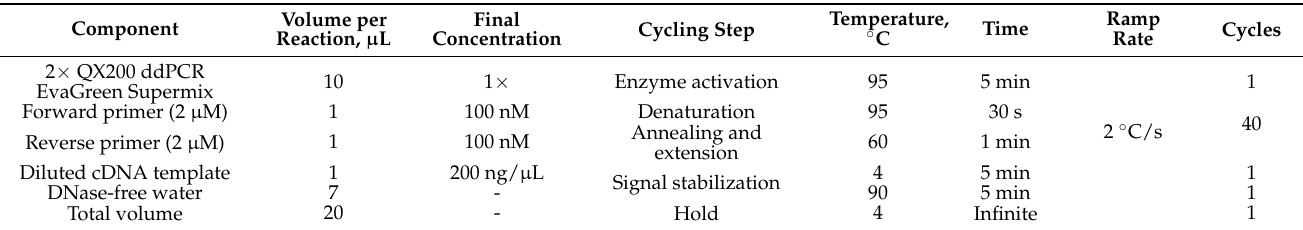
Table 1. Reaction system and procedure of droplet digital